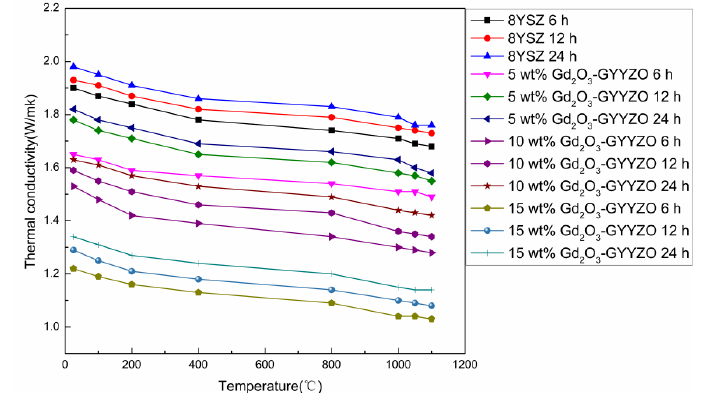
Figure 4. Thermal conductivities of the sintered bulk materials.